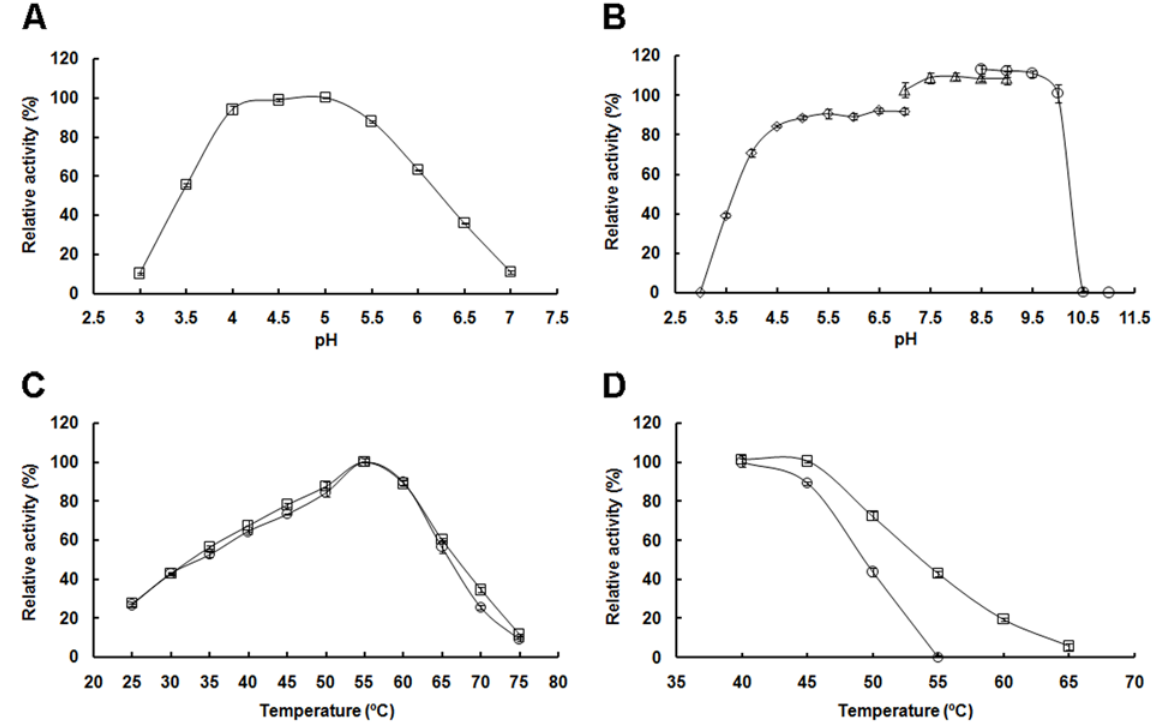
Fig 4. Effects of pH and temperature on the enzyme activity and stability of TpAA. (A) Effects of pH on the enzyme activity. The enzyme activities were measured at 37°C and pH 3.0 – 7.0 in 0.1 M citrate-phosphate buffer. (B) Effects of pH on the enzyme stability. The enzyme was mixed with 0.1 M buffers at pH 3.0 – 11.0 (pH 3.0 – 7.0, citrate-phosphate buffer; pH 7.0 – 9.0, Tris-HCl buffer; pH 8.5 – 11.0, glycine-NaOH buffer) and incubated at 4°C for 24 hours. The residue activities were measured at 55°C and pH 5.0. (C) Effects of temperature on the enzyme activity in the presence ( (cid:3) ) or absence ( □ ) of 5 mM CaCl 2 . The enzyme activities were measured at 25 – 75°C and pH 5.0 in the presence ( (cid:3) ) or absence ( □ ) of 5 mM CaCl 2 . (D) Effects of temperature on the enzyme stability in the presence ( (cid:3) ) or absence ( □ ) of 5 mM CaCl 2 . The enzyme was incubated at 40 – 65°C for 1 hour in the presence ( (cid:3) ) or absence ( □ ) of 5 mM CaCl 2 . The residue activities were measured at 55°C and pH 5.0. All values are expressed as percentages of the activity of untreated enzyme.